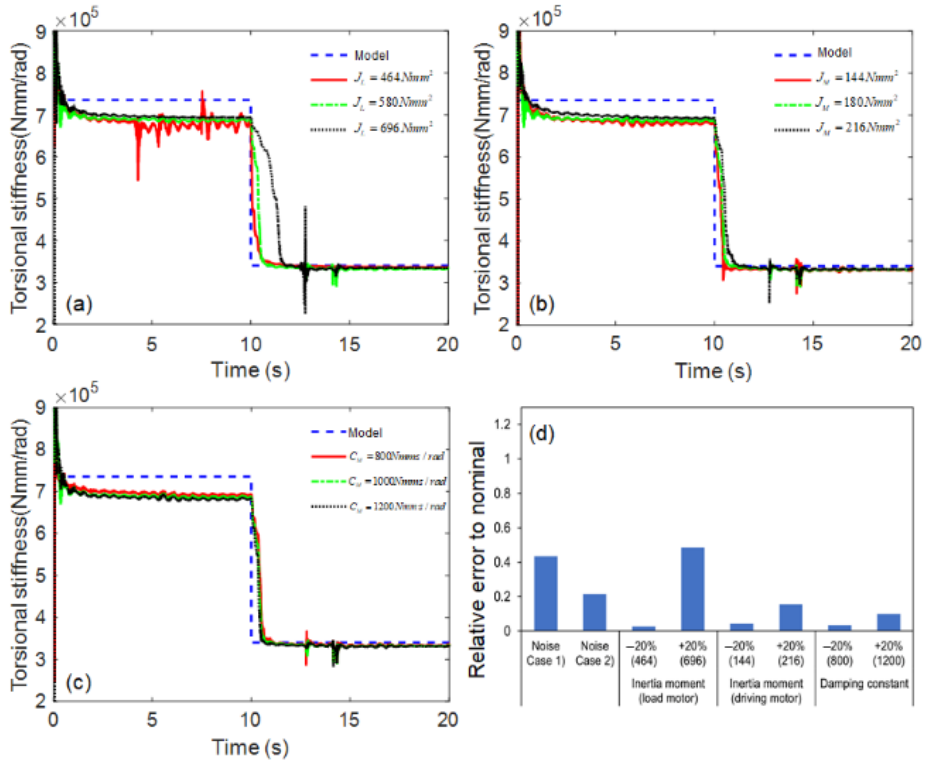
Figure 8. Simulation results of shaft stiffness estimation under parametric uncertainty: ( a ) inertia moment of load motor, ( b ) inertia moment of driving motor, ( c ) damping constant, and ( d ) relative errors.